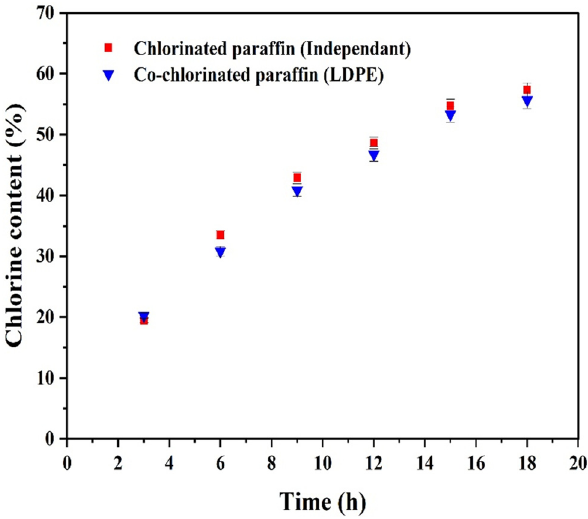
Figure 11: Comparison of independently chlorinated para ffi n and co - chlorinated para ffi n with